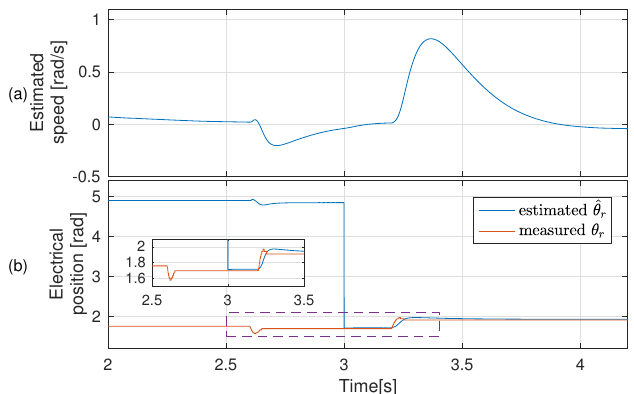
Figure 18. Proposed torque pulse-based rotor polarity